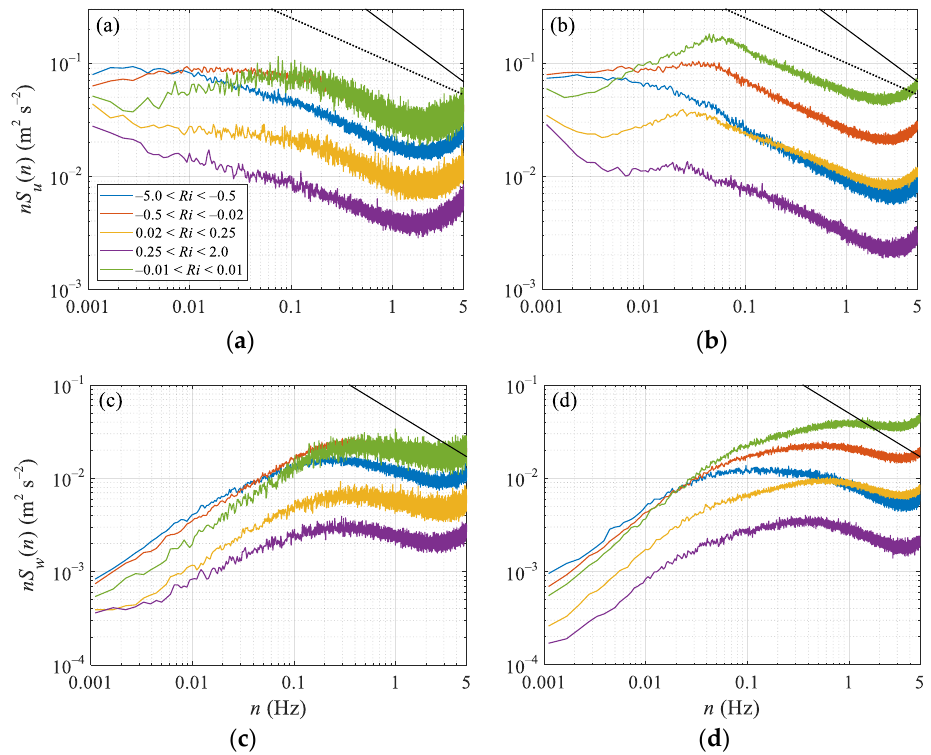
Figure 9. The spectra of longitudinal wind ( a , b ) and vertical velocity ( c , d ) in the directions of northwest ( a , c ) and southeast ( b , d ). The color curves in the figure indicate different stability intervals. The solid and dotted black lines are the −2/3 and −2/5 law curves, respectively.